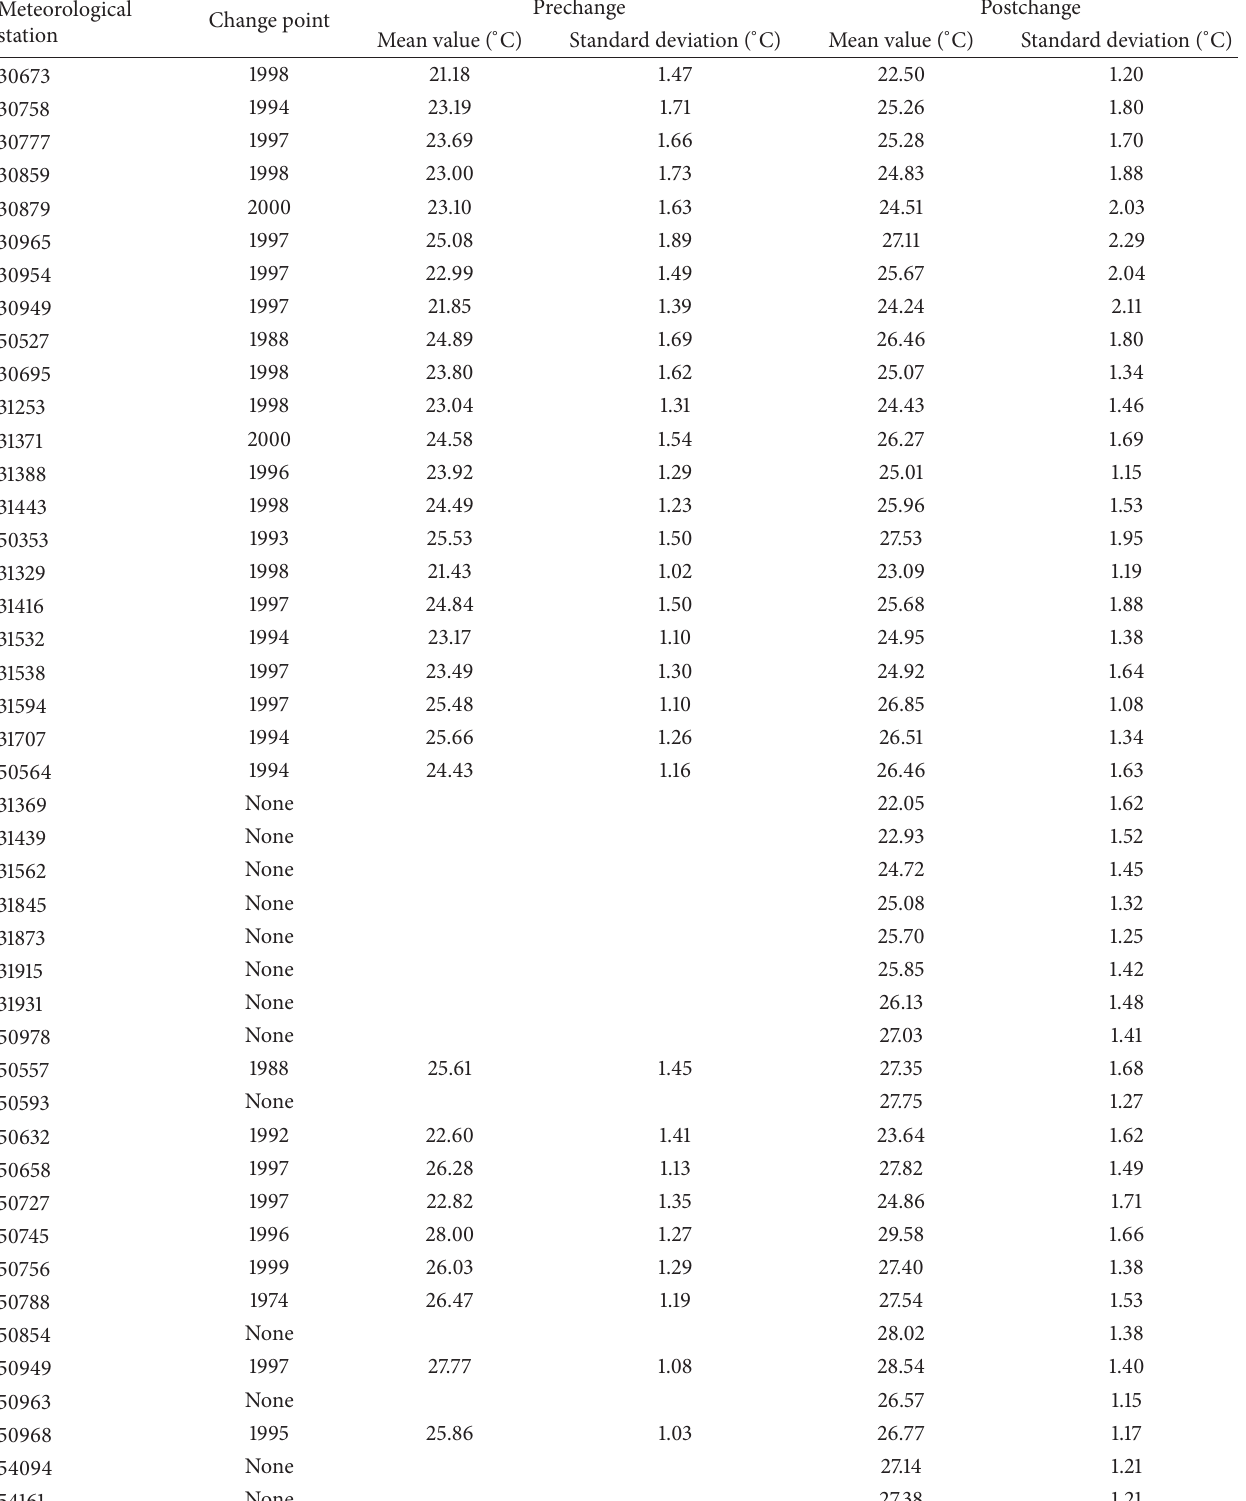
Table 2: Climate change detection and descriptive statistics of the annual maximum temperature